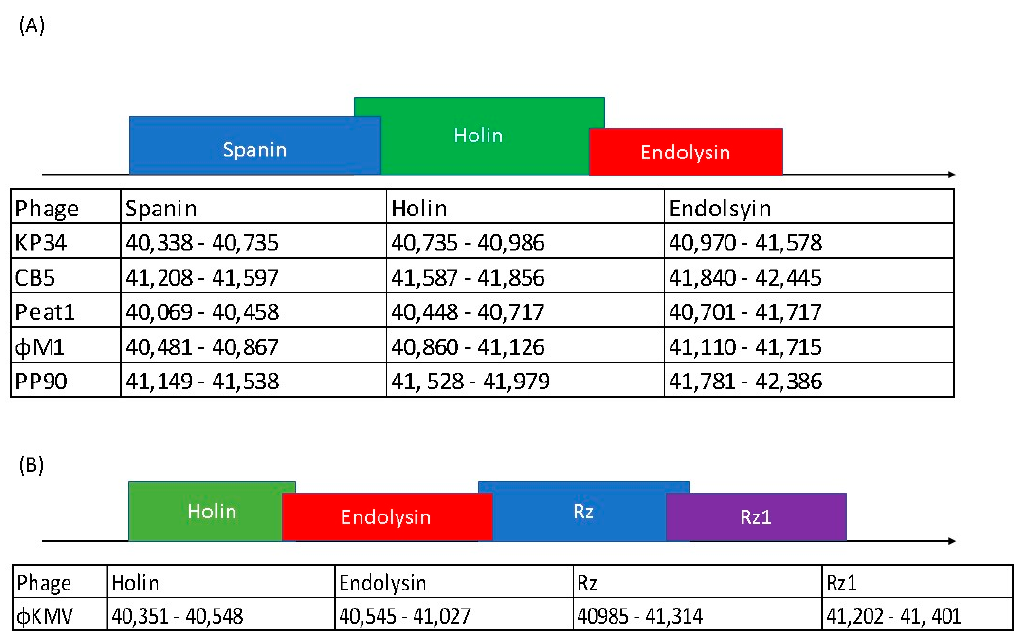
Figure 8. Lysis cassette scheme of ( A ) Klebsiella phage KP34 and PhiM1-like phages compared to ( B ) Pseudomonas phage φ KMV.